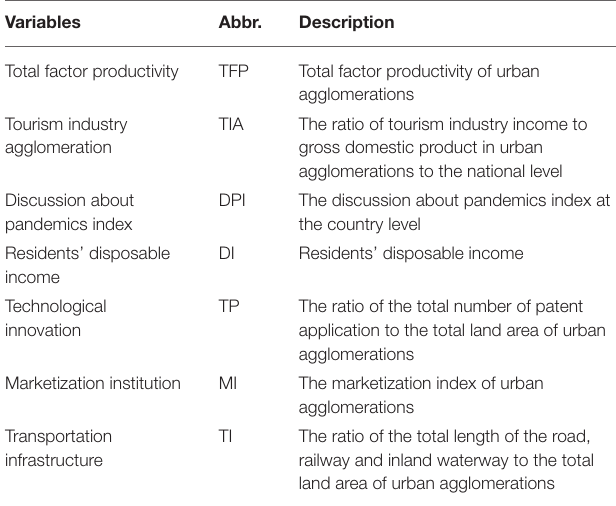
TABLE 1 | Calibrated variables.